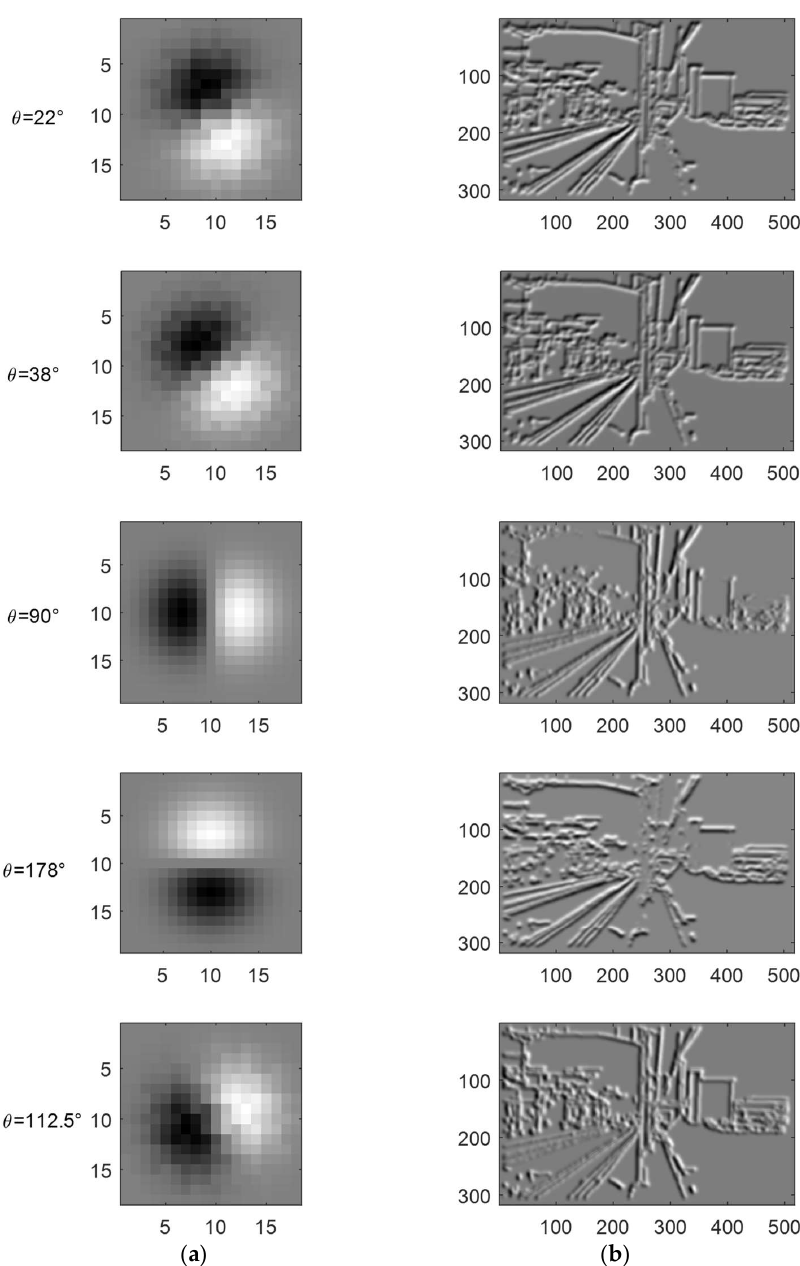
Figure 6. Different kernels and the convolution results of CIE-lab color L channel. ( a ) First order derivative Gaussian kernels rotated by five angles. ( b ) Results of the Gaussian convolution.